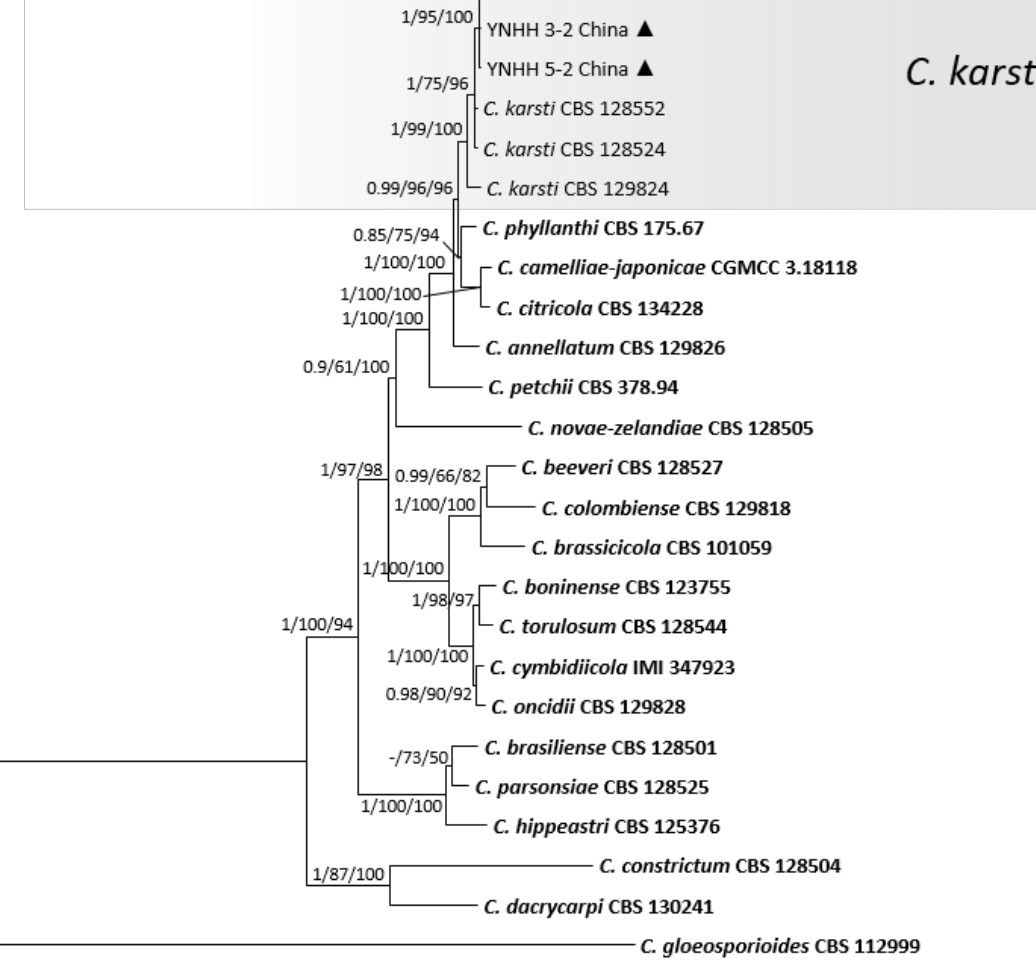
19 of 35 Figure 4. A Bayesian inference phylogenetic tree of 61 isolates in the C. gloeosporioides species complex. C. boninense (CBS 123755) was used as the outgroup. The tree was built using combined sequences of the ACT , CAL , CHS-1 , GAPDH , ITS, and TUB2 . BI posterior probability values (BI ≥ 0.70), MP bootstrap s upport values (MP ≥ 50%), and RAxML bootstrap support values (ML ≥ 50%) were shown at the nodes (BI/MP/ML). Tree length = 1303, CI = 0.76, RI = 0.84, RC = 0.63, HI = 0.24. Ex-type strains are in bold. Circles indicate isolates from fruits, and triangles indicate isolates from leaves. Regarding the C. boninense species complex, in the multilocus analyses (gene/locus boundaries of ITS: 1 – 553, GAPDH : 558 – 843, CHS-1 : 848 – 1127, HIS3 : 1132 – 1524, ACT : 1529 – 1804, TUB2 : 1809 – 2310, CAL : 2315 – 2763) of three isolates from peaches in this study, from 21 reference isolates of C. boninense species complex and one outgroup strain C. gloeosporioides CBS 112999, 2763 characters including the alignment gaps were